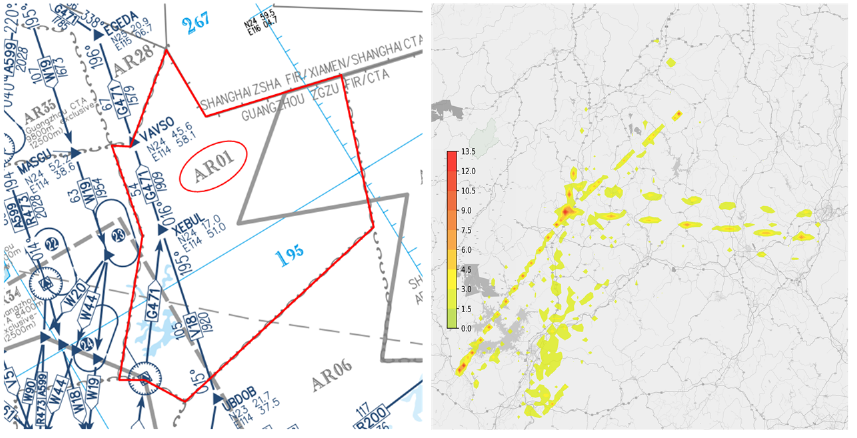
Figure 6. Area of Guangzhou